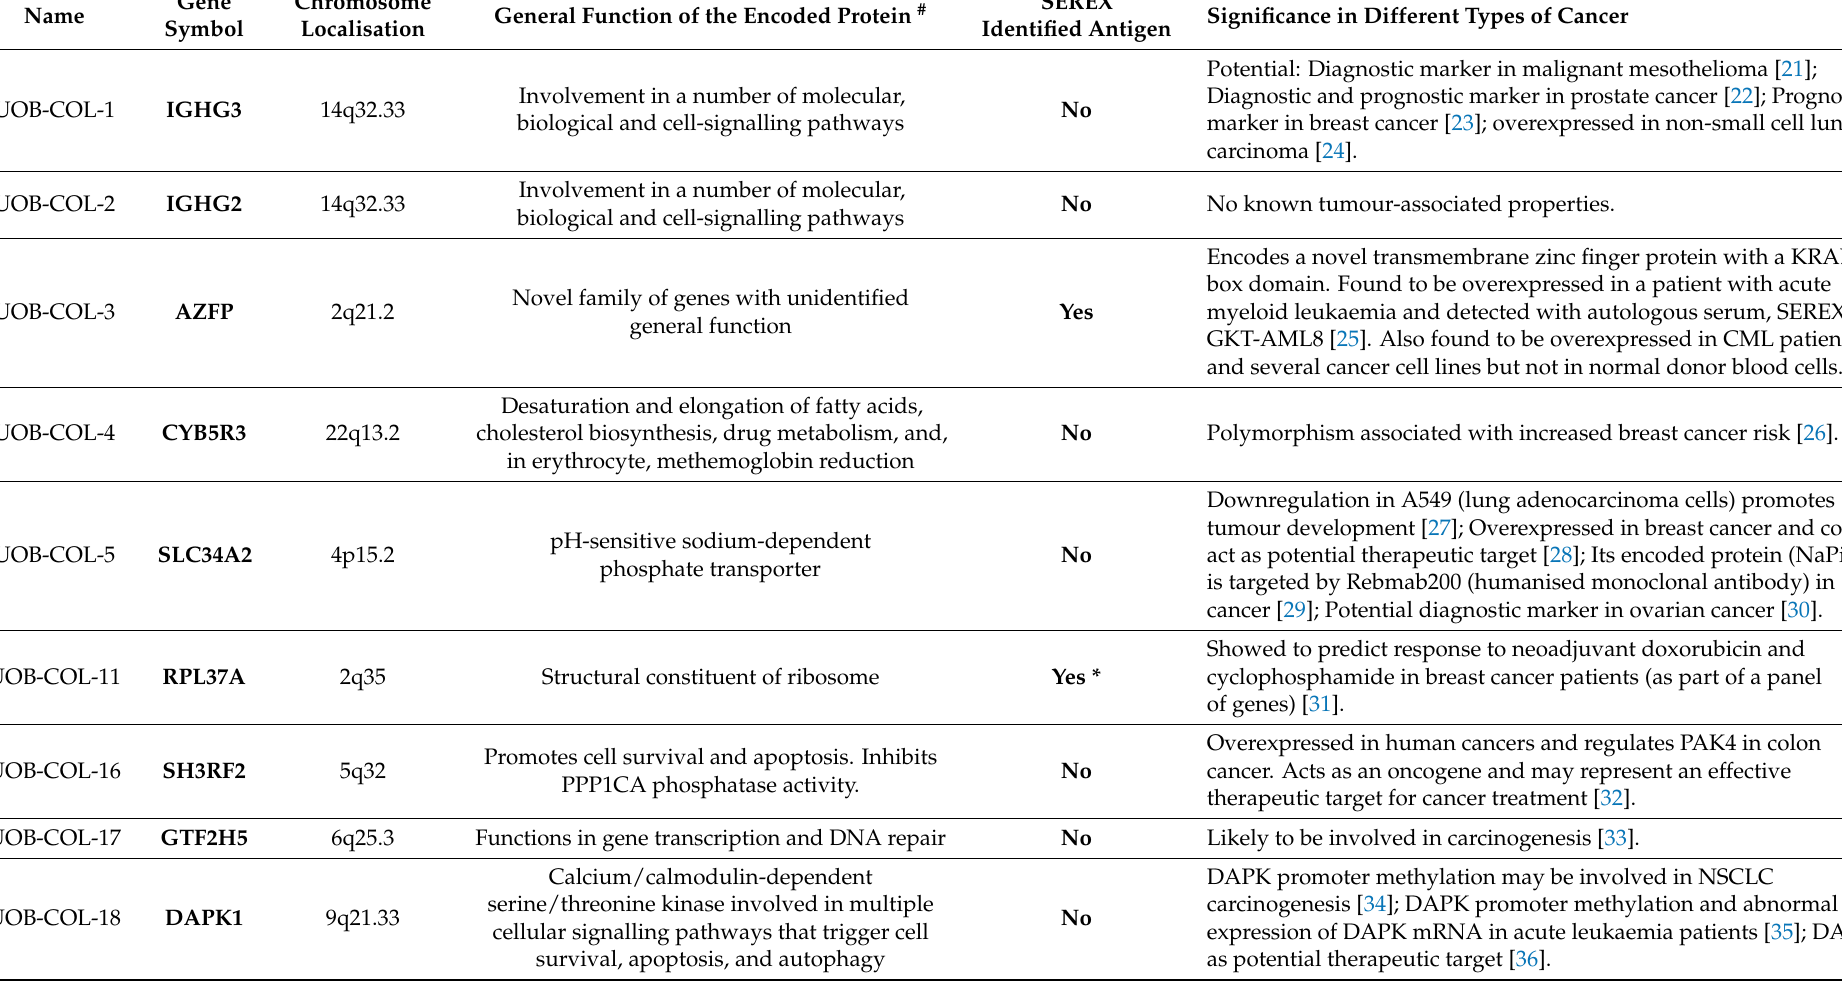
Table 1. BLAST results for the nine previously identified antigens identified by CRC CLR